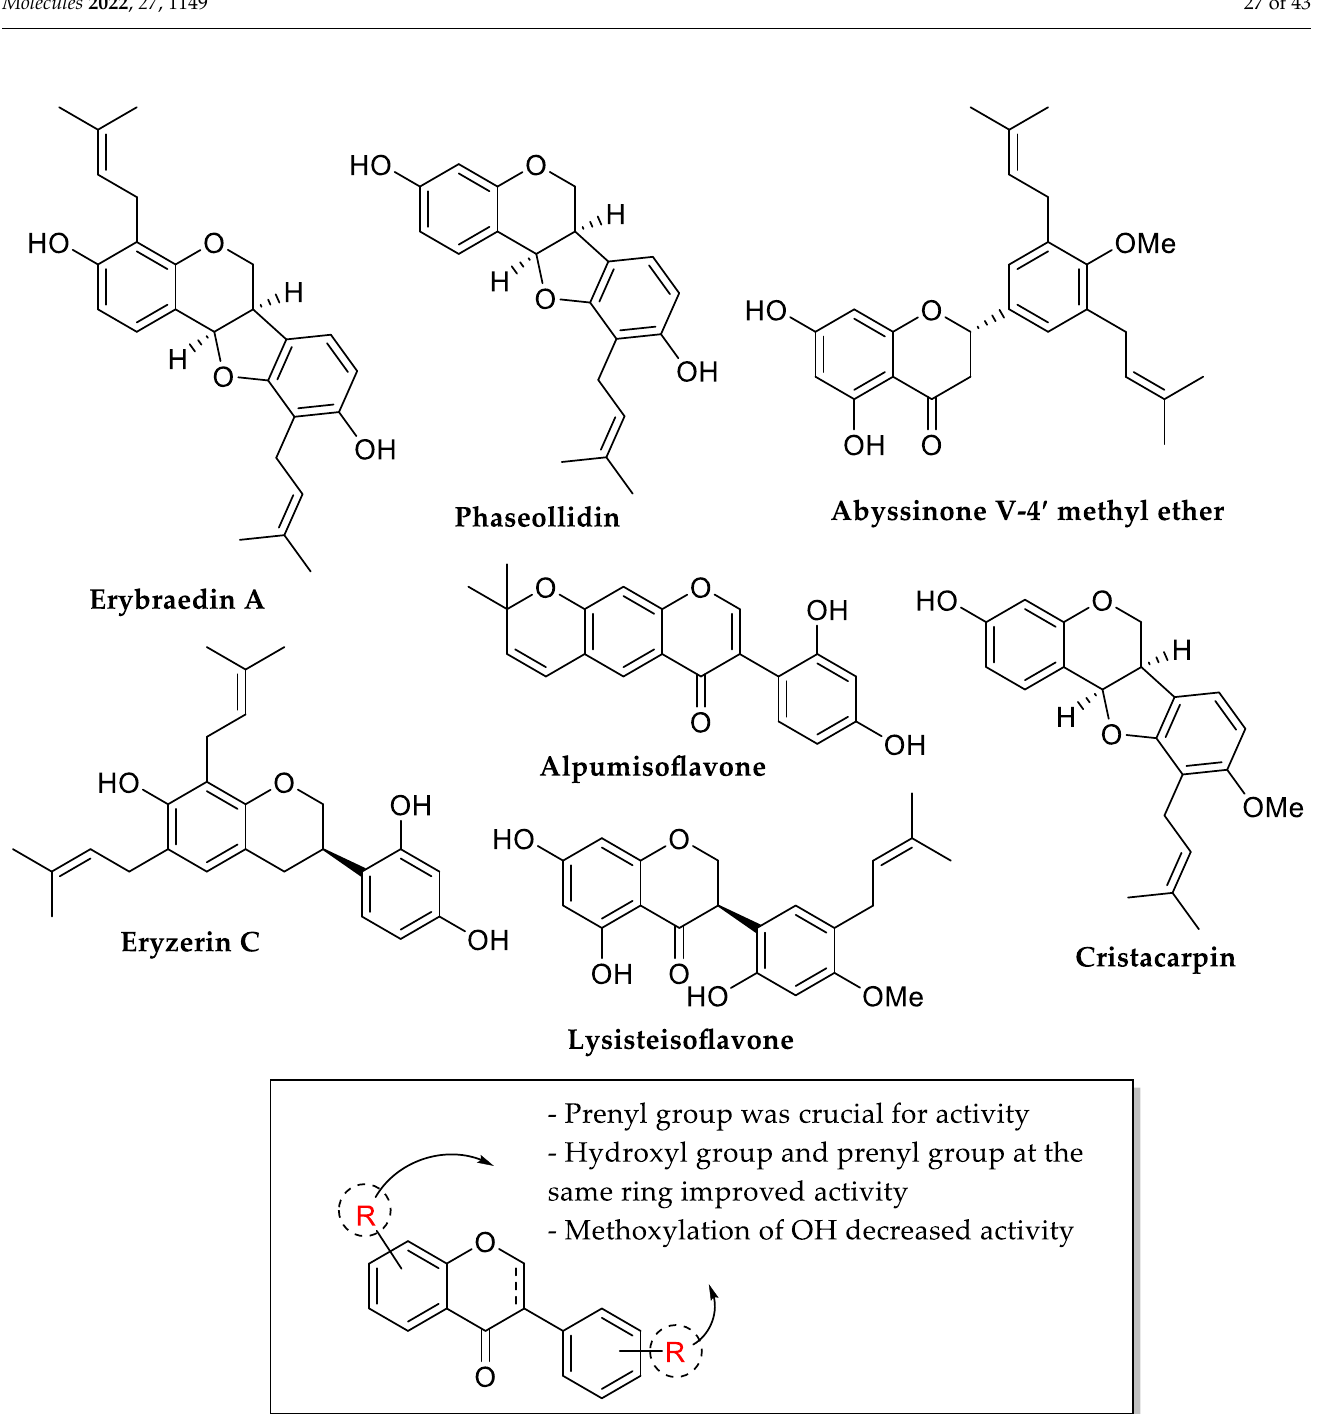
Figure 26. Structures of isoflavones and derivatives from the bark of Erythrina lysistemon and the SAR analysis of isoflavones as antibacterial agents [95].